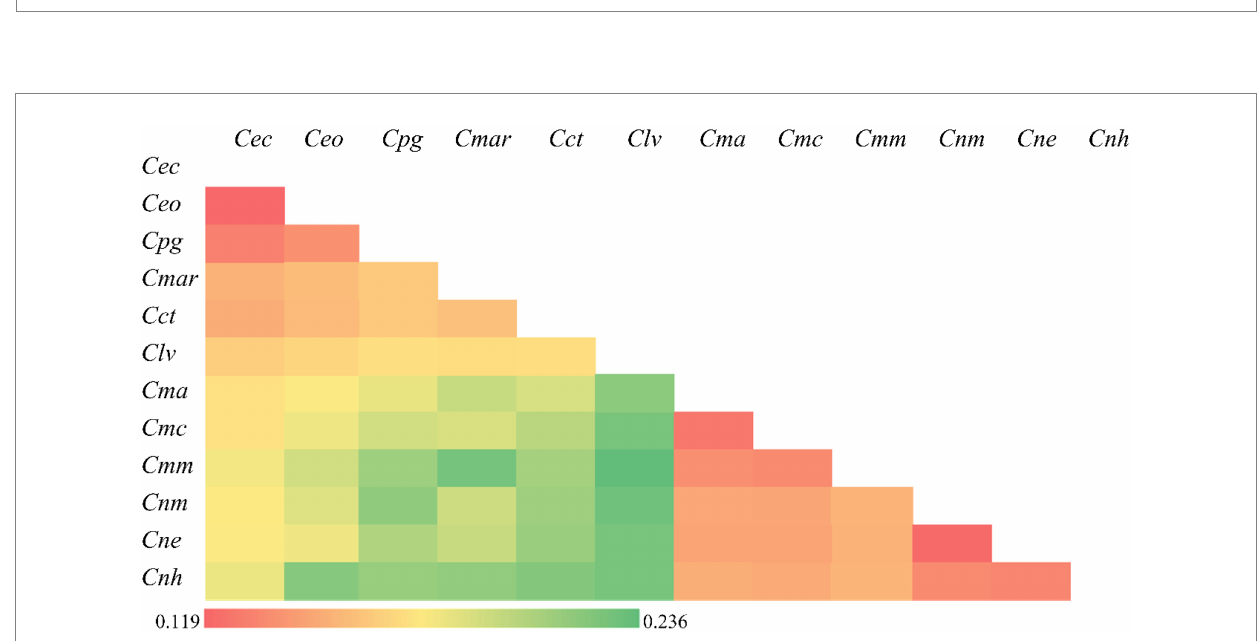
FIGURE 6 Heatmap of pairwise genetic distance of 13 PCGs of Monetaria moneta ( Cmm ), Naria helvola ( Cnh ), Mauritia arabica ( Cmar ), Naria miliaris ( Cnm ), Naria erosa ( Cne ), Monetaria caputserpentis ( Cmc ), Purpuradusta gracilis ( Cpg ), Lyncina vitellus ( Clv ), Erronea onyx ( Ceo ), Erronea caurica ( Cec ), Cypraea tigris ( Cct ), and Monetaria annulus ( Cma